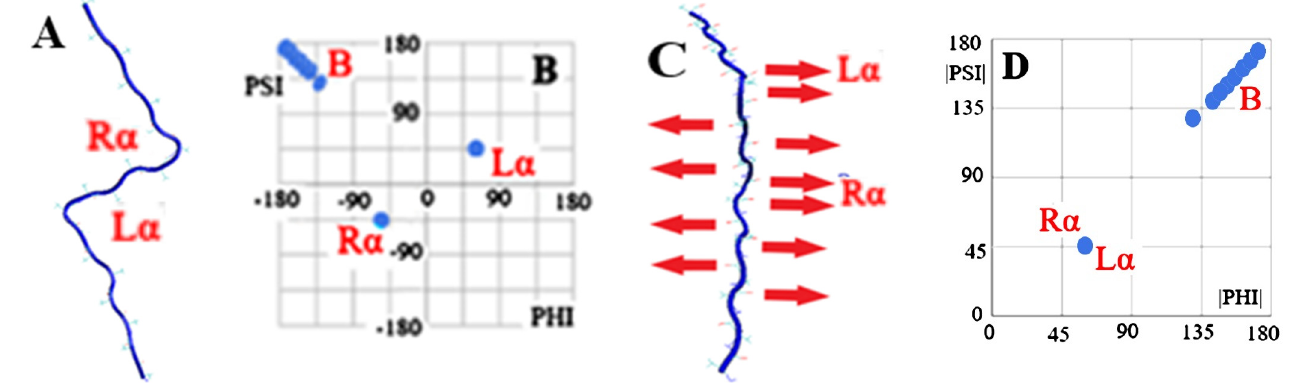
Figure 1. An example of a poly-alanine ( A ) structure with Phi and Psi angles ( B ) with hydrogen bond turns highlighted (a representation of the C=O group orientation) ( C ) with the Phi and Psi angles after transformation |Phi| = |Psi| ( D ).